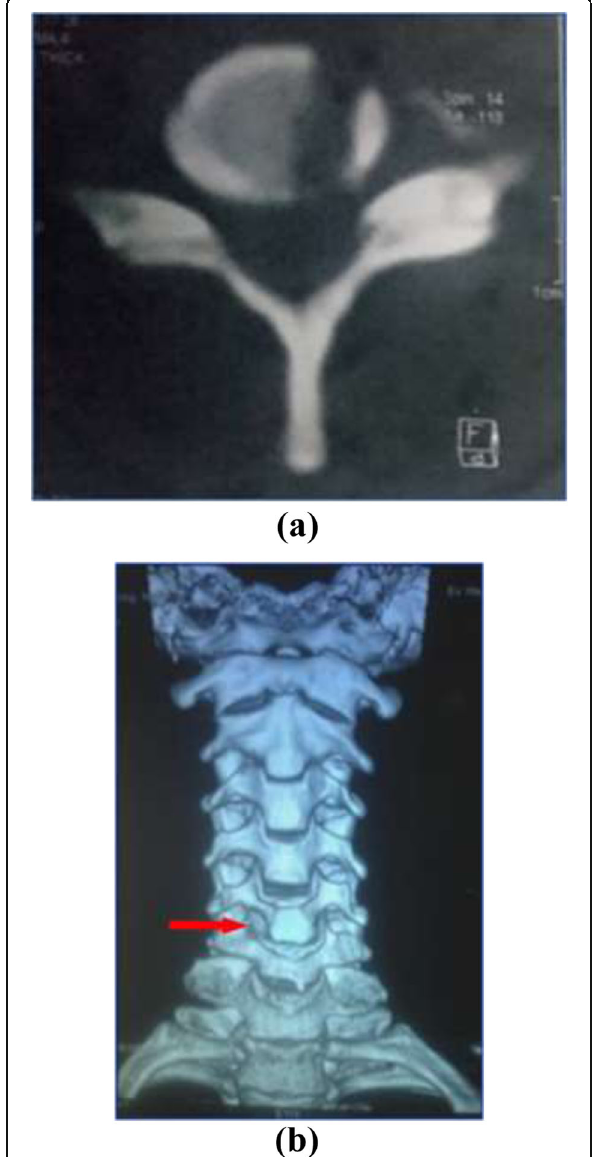
Fig. 3 a Postoperative axial CT scan showing C5 – 6 right foraminotomy. b 3D CT scan of same